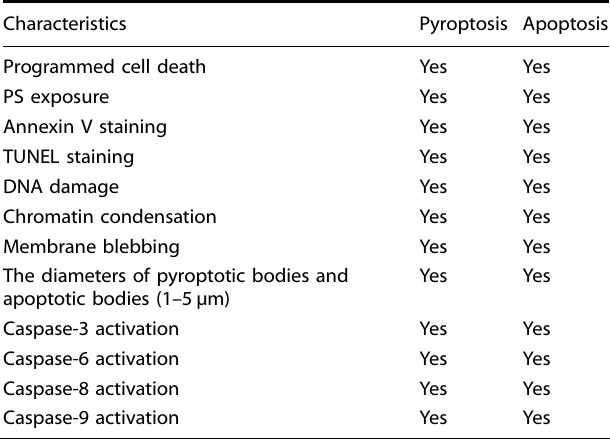
Table 1. Similarities between pyroptosis and apoptosis Characteristics